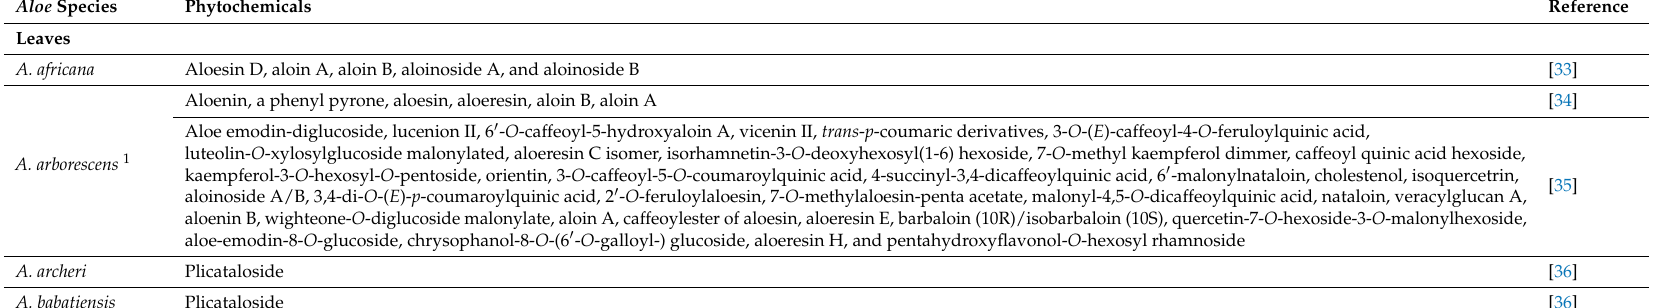
Table 1. Phytoconstituents of Aloe species detected by high-performance liquid chromatography (HPLC) and reversed-phase